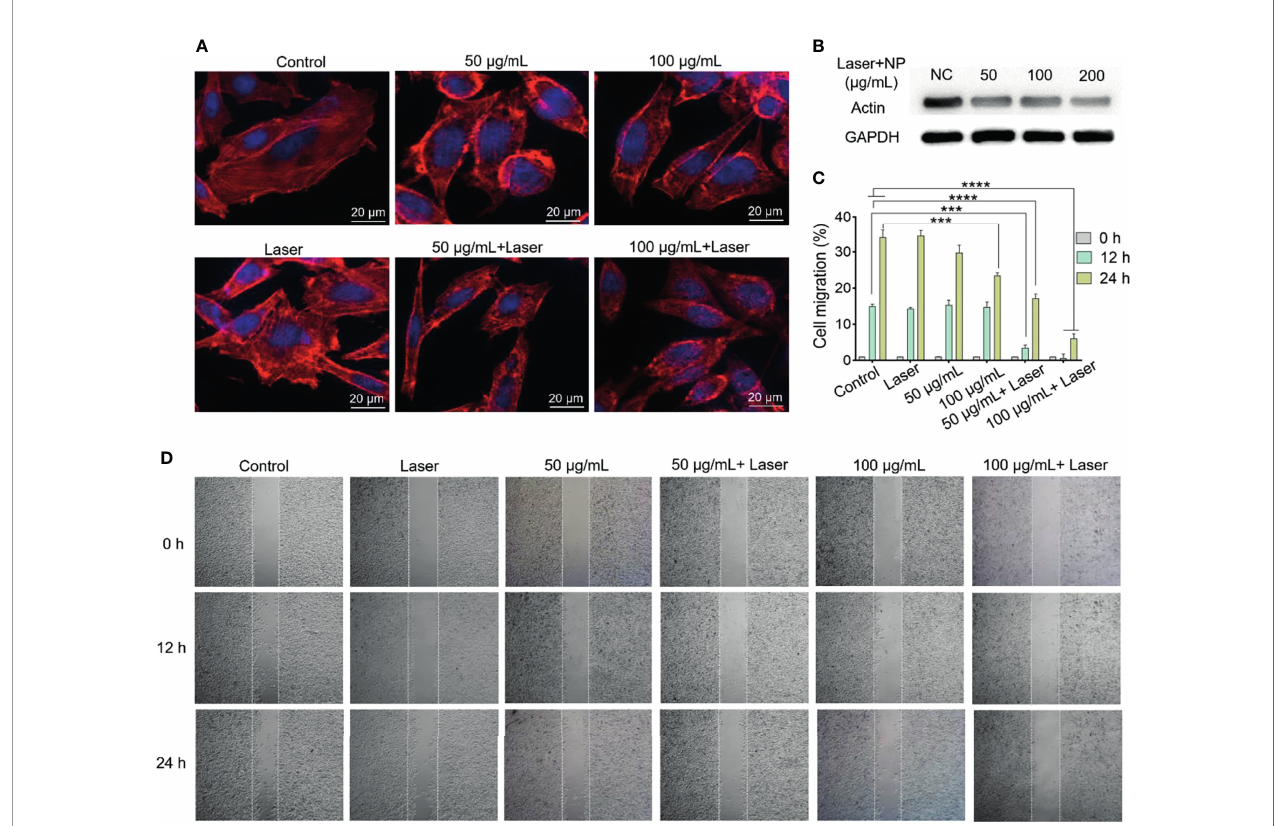
FIGURE 4 | (A) Immuno fl uorescence images and (B) Western blot analysis of SKOV-3 actin staining after various treatments. (C) Corresponding migration rate. All values are presented as means ± standard errors of the mean (SEM); ****p < 0.0001, ***p < 0.001. (D) The migration performance of SKOV-3 cells with various